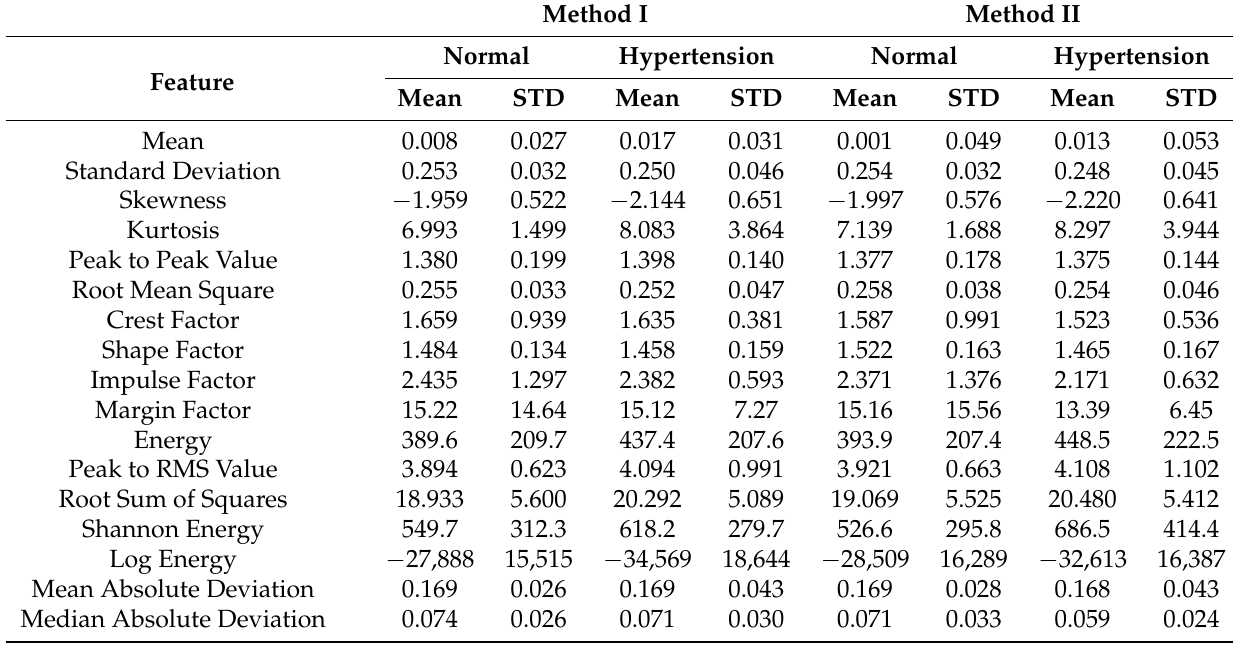
Table 6. Statistical data of all extracted features for both